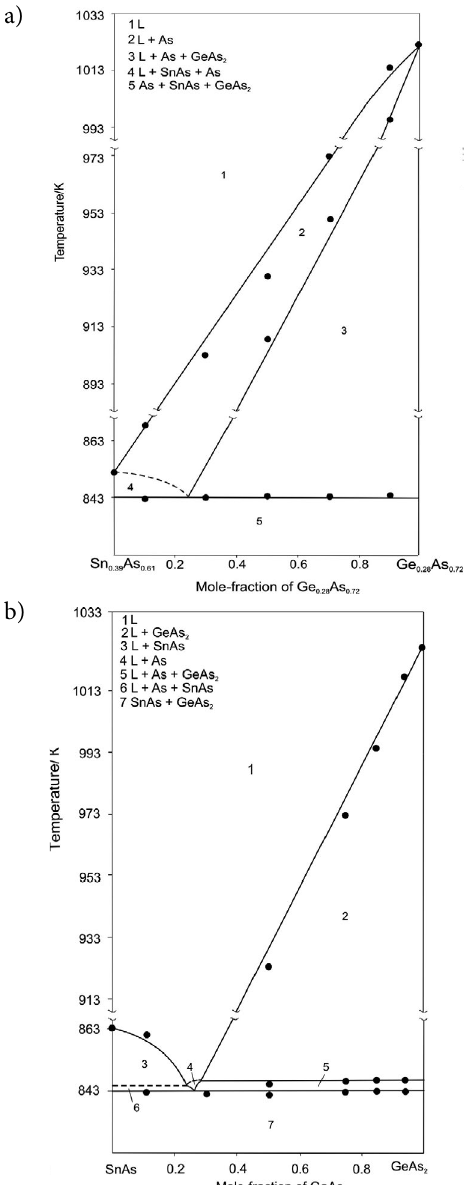
Figure 10. T-x diagrams of polythermal sections Sn 0.39 As 0.61 – Ge 0.28 As 0.72 (а) and SnAs–GeAs 2